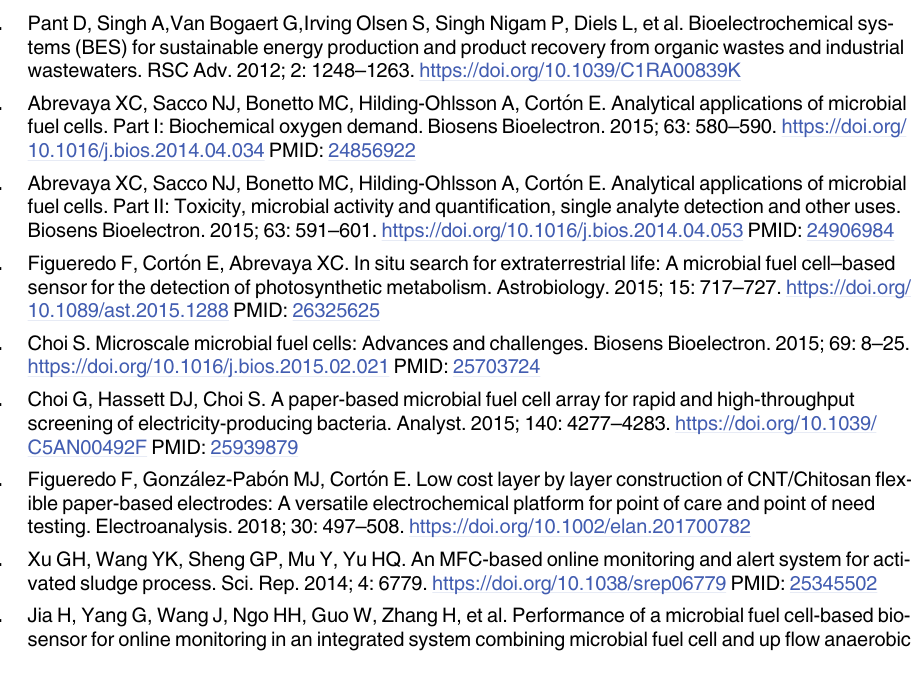
S1 File. (Fig A) Schematic representation of the setup for conductivity measurement. (Fig B) Schematic representation of the setup for oxygen mass transport coefficient determination. (Fig C) Paper based micro-scale MFC design and performance. (Table A) Start-up and response time of MFC-based